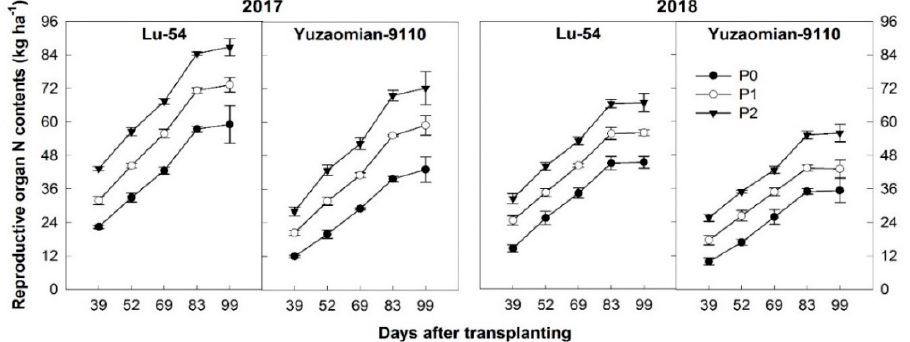
Figure 3. The accumulation of total N contents (kg ha − 1 ) in reproductive organ of cotton plant for Lu- 54 and Yuzaomian-9110 in 2017 and 2018. The treatments P0, P1, and P2 represent the P levels, i.e., 0, 100, and 200 kg P 2 O 5 ha − 1 . The data are the means of three replications ± standard error.